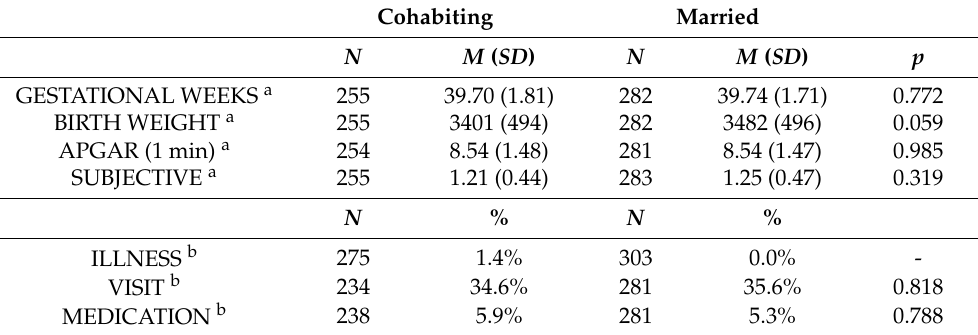
Table 5. Infant Outcome by Marital